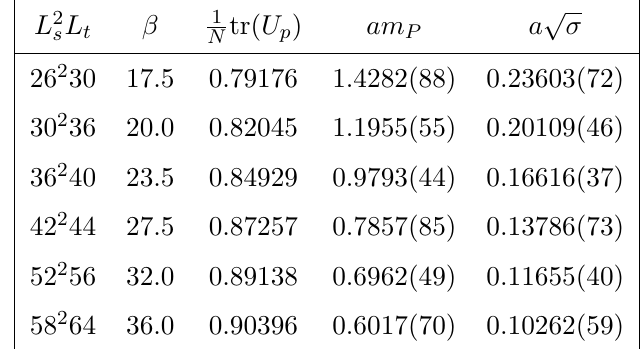
Table 13 . SO(5) average plaquette values, (cid:13)ux loop masses, and string tensions.